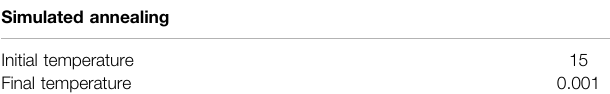
TABLE 2 | Methods and parameters used for